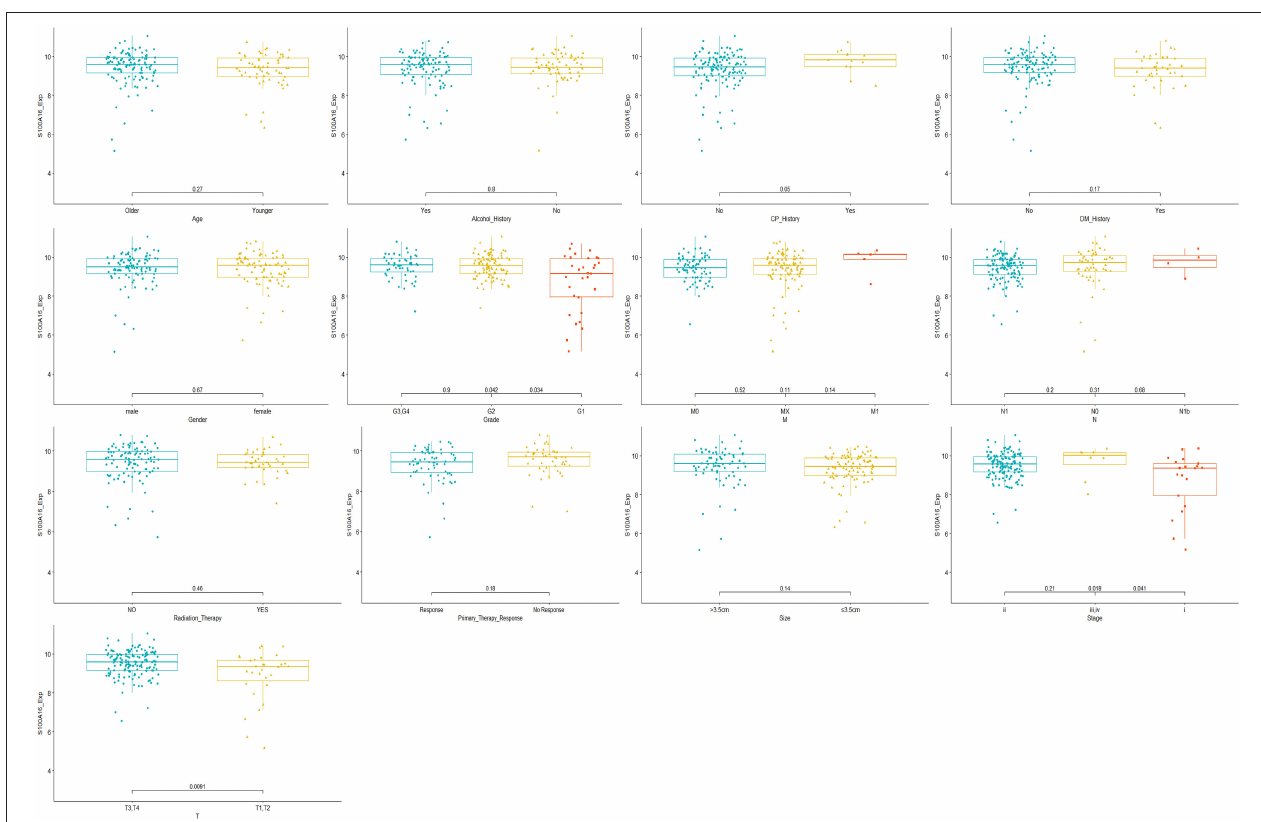
FIGURE 9 | Clinical correlation analysis based on TCGA database.